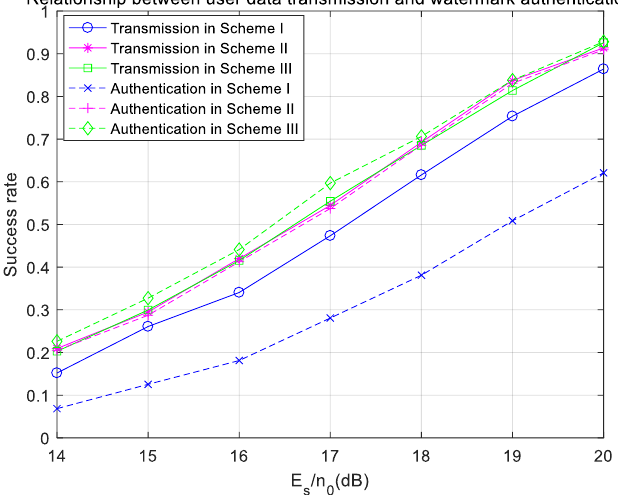
Figure 18. Success rates of user-data transmission and watermark authentication under ideal syn- chronization in the fading channel.